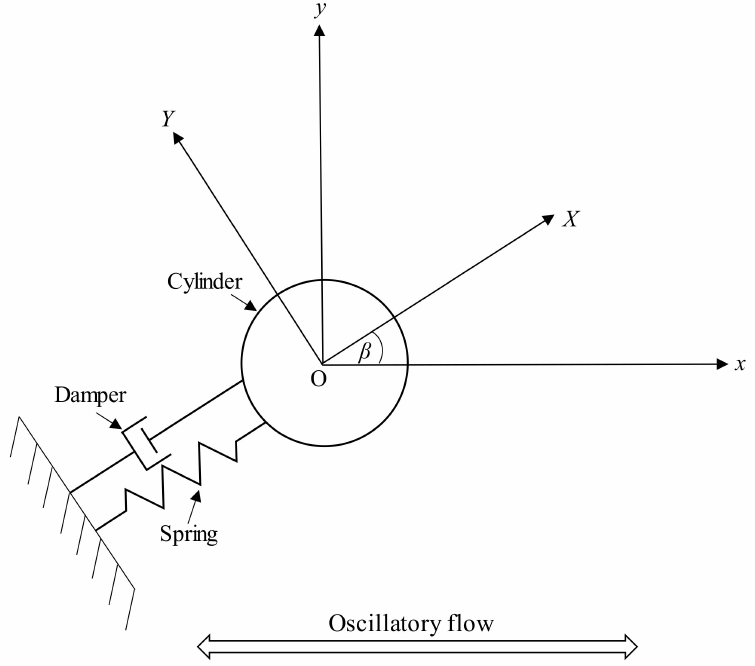
Figure 1. Sketch of circular cylinder vibrating at β in oscillatory